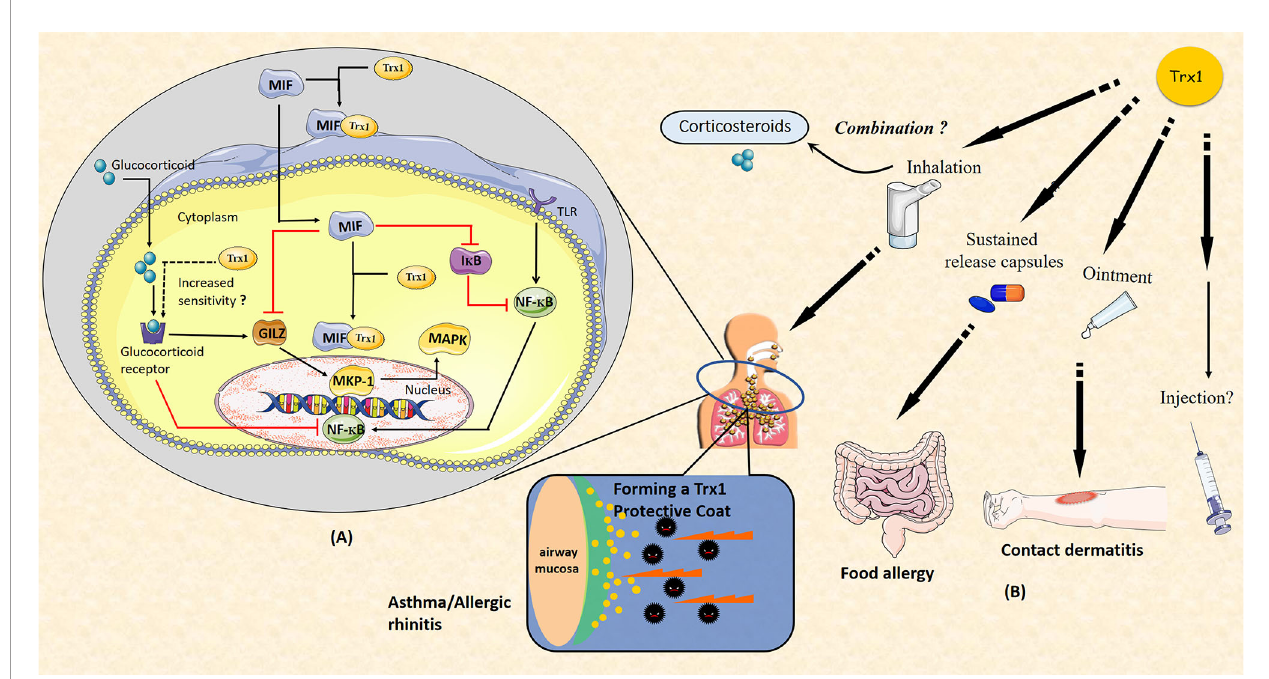
FIGURE 4 | (A) Thioredoxin-1 (Trx1) improves glucocorticoid (GC) resistance through macrophage migration inhibitory factor (MIF). MIF impairs GC sensitivity via the inhibition of MAP kinase phosphatase-1 (MKP-1). MKP-1 is induced by GC to mediate GC inhibition of ERK, JNK, and p38MAPK activities as well as cytokine production. MIF inhibits GC-induced leucine zipper (GILZ) expression through unique effects on the expression of transcription factor and phosphorylation. MKP-1 and MAPK activation are regulated by MIF via GILZ. MIF also affects the NF- k B/I k B signal cascade. Trx1 may directly bind to GC receptor and enhance the response of cells to GCs. Both intracellular and extracellular Trx1 bind to MIF and form a heterodimer to prevent MIF entry into cells and MIF-induced GC resistance. (B) Potential clinical applications of Trx1 in allergic diseases. Administration of Trx1 suppresses the excessive allergic in fl ammatory response. Future clinical applications of Trx1 could include treatment of asthma or allergic rhinitis with a Trx1 inhaler, topical application for patients with contact dermatitis, and/or oral delivery for those with food allergies. It may also be promising to combine Trx1 with corticosteroids. Finally, Trx1 could potentially be administered as an intravenous